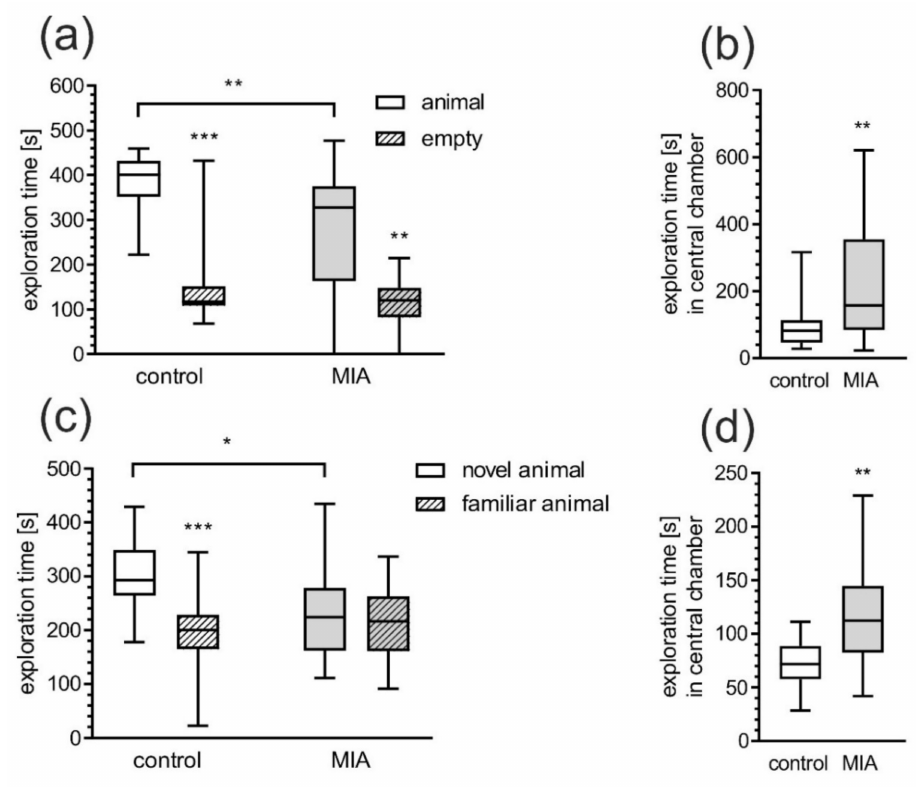
Figure 4. MIA induces social behavior alteration in adolescent o ff spring. E ff ects of prenatal LPS exposure on sociability assessed by three chambers test at PND 50-51. ( a ) Time spent exploring animal cage or empty cage. ( b ) Time spent in central chambers (during phase II). ( c ) Time spent exploring familiar animal or novel animal. ( d ) Time spent in central chambers (during phase III). Data represent medians with interquartile range, minimum, and maximum (control n = 15, MIA = 24). * p < 0.05, ** p < 0.01, *** p < 0.001, compared to control group, Mann-Whitney U